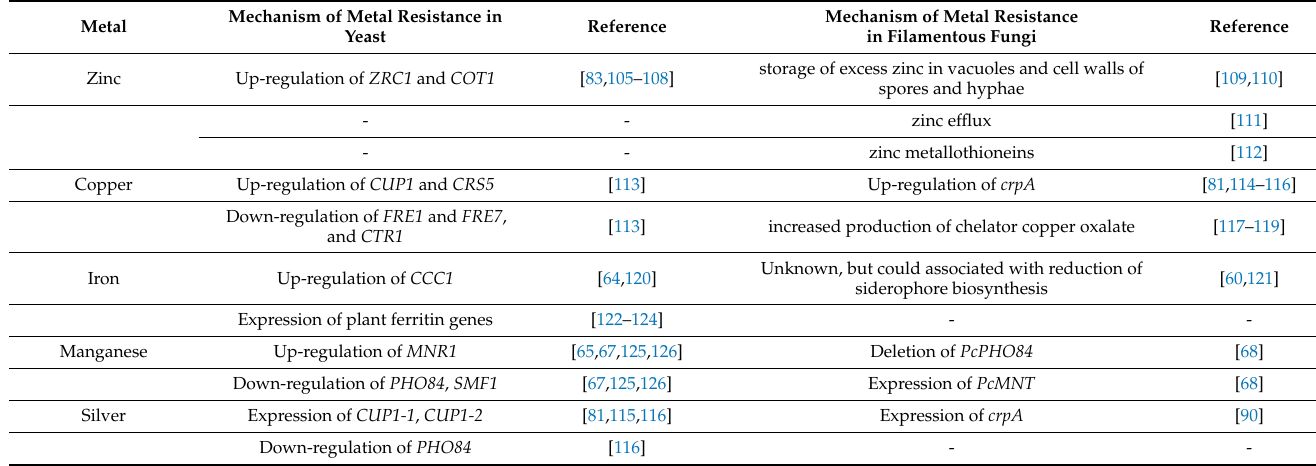
Table 3. Mechanisms of metal resistance in yeast and filamentous